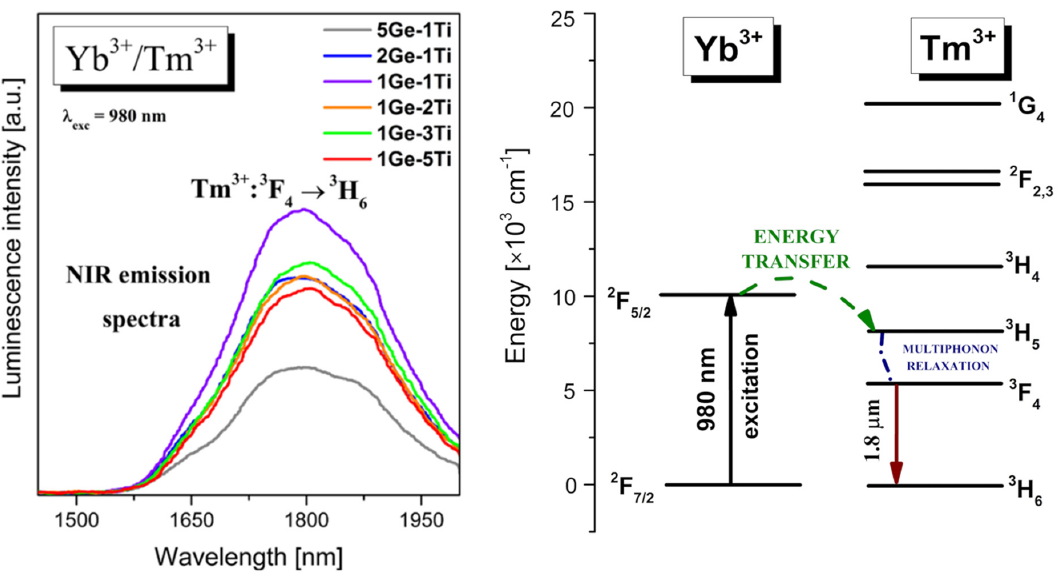
Figure 4. Near ‐ infrared emission spectra and energy level diagram for titanate–germanate glasses co ‐ doped with Yb 3+ /Tm 3+ .